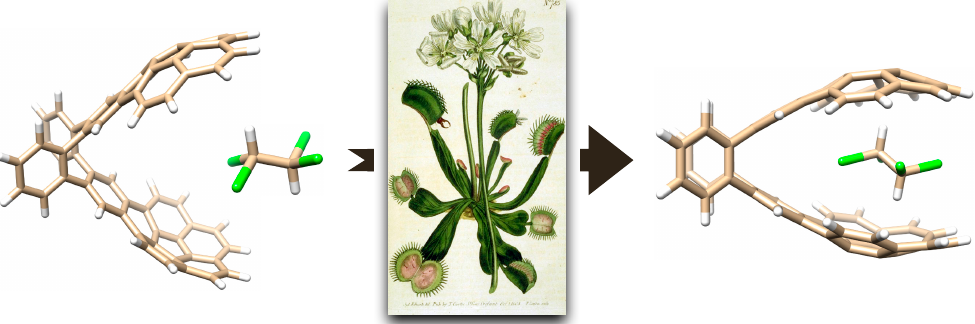
Figure 1. Motivational scheme for the present study.